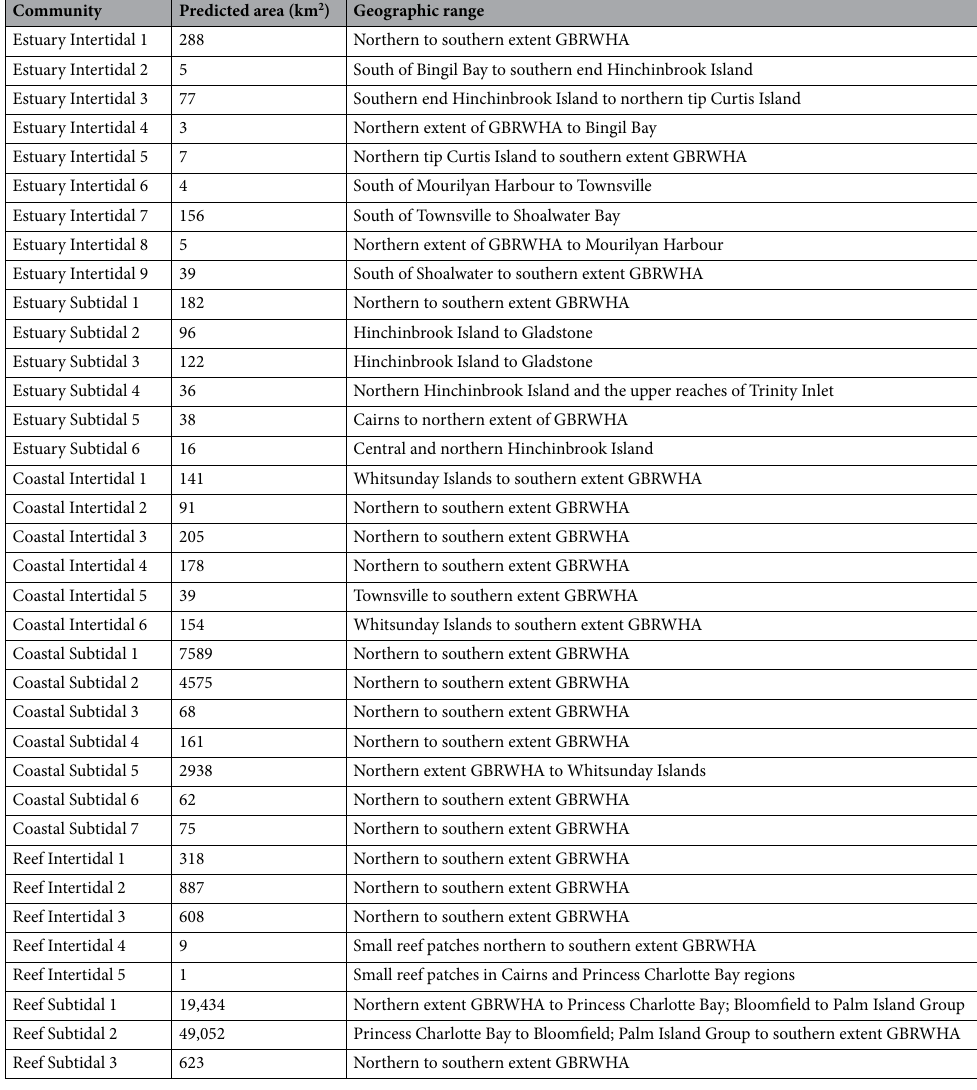
Table 3. Seagrass communities in the Great Barrier Reef World Heritage Area and adjacent estuaries, including predicted area and geographic range. See Figs. 5, 6 and 7 for